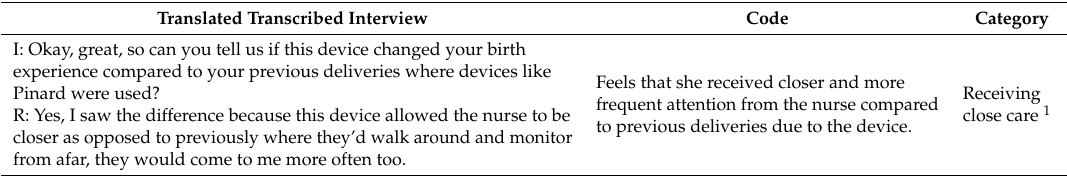
Table 1. Example of the analysis process.